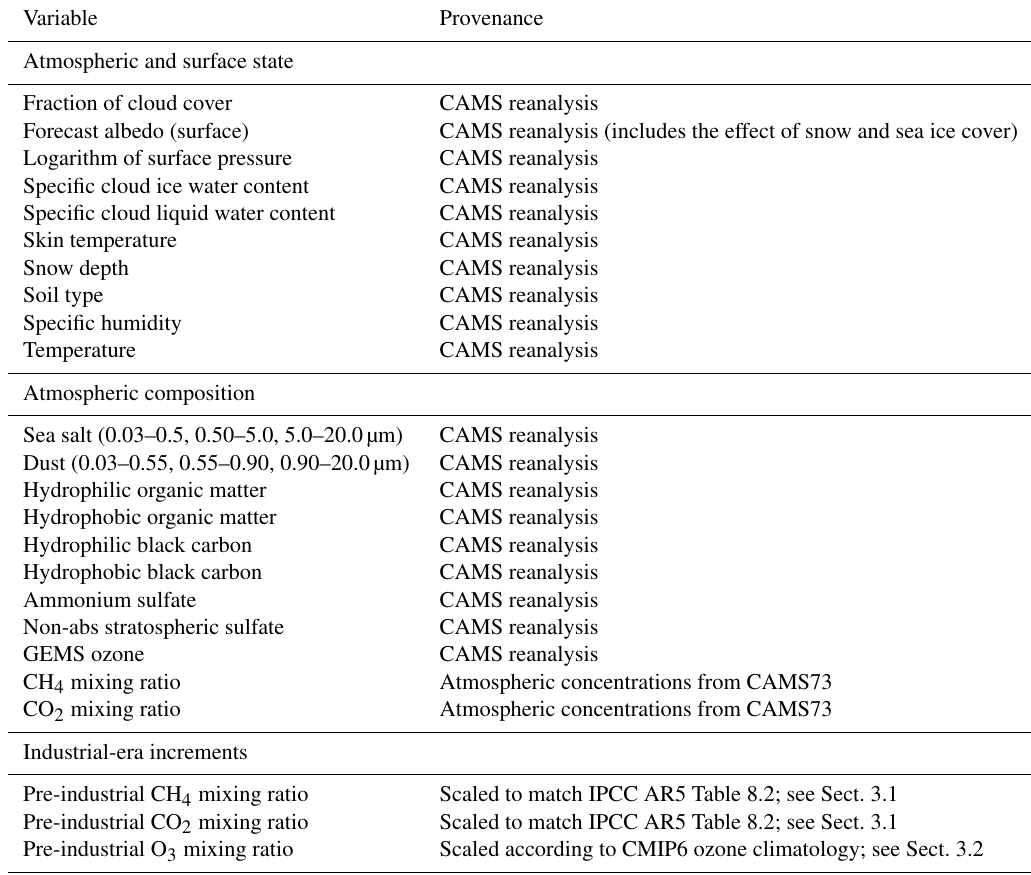
Table 2. List of variables used by the offline radiative-transfer model ecRad and their provenance. All variables are set as daily averages.